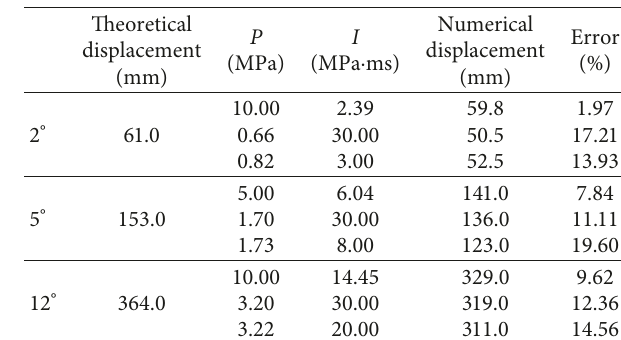
Table 6: Displacement comparison.